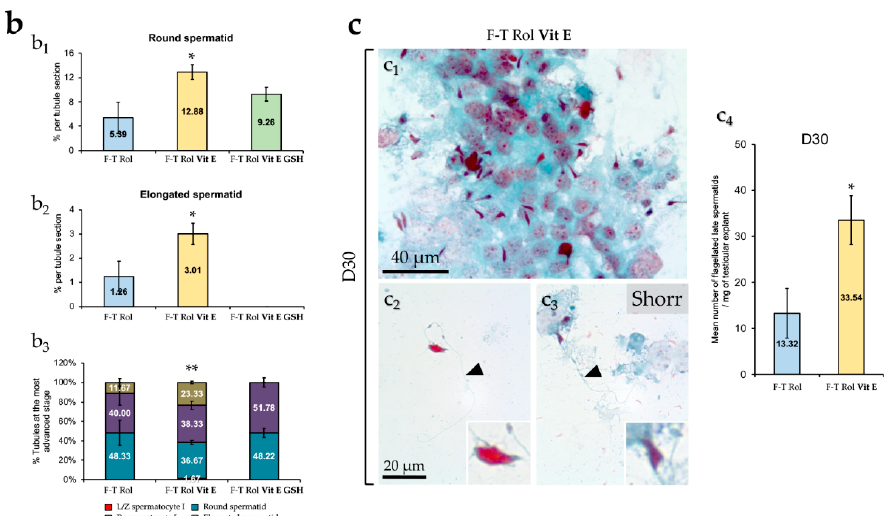
Figure 6. Effect of antioxidant supplementation on in vitro maturation of frozen-thawed prepubertal mouse testicular fragments during the first wave of spermatogenesis. ( a ) Histological evaluation of germ cell differentiation into spermatids according to the culture conditions tested. At D0, seminiferous tubule sections, stained with hematoxylin eosin, contained only spermatogonia (blue boxes) as germ cell ( a 1 ). F-T prepubertal testicular fragments cultured without antioxidant